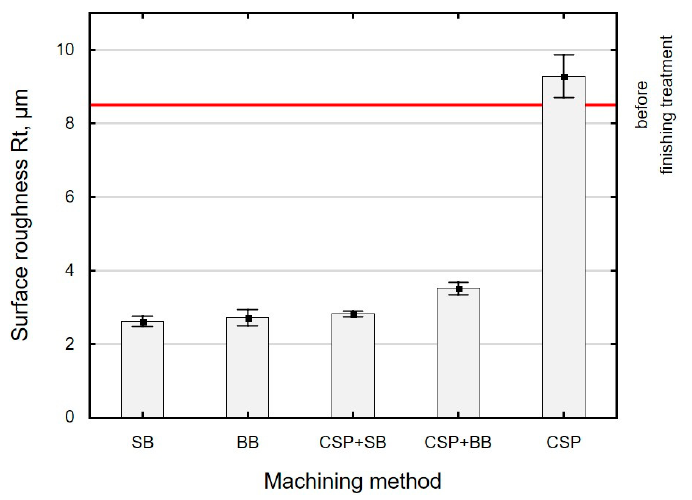
Figure 7. Effect of the finishing method on the surface roughness parameter Rt (SB—slide burnishing, BB—ball burnishing, CSP + SB—centrifugal shot peening + slide burnishing, CSP + BB—centrifugal shot peening + ball burnishing, CSP—centrifugal shot peening).